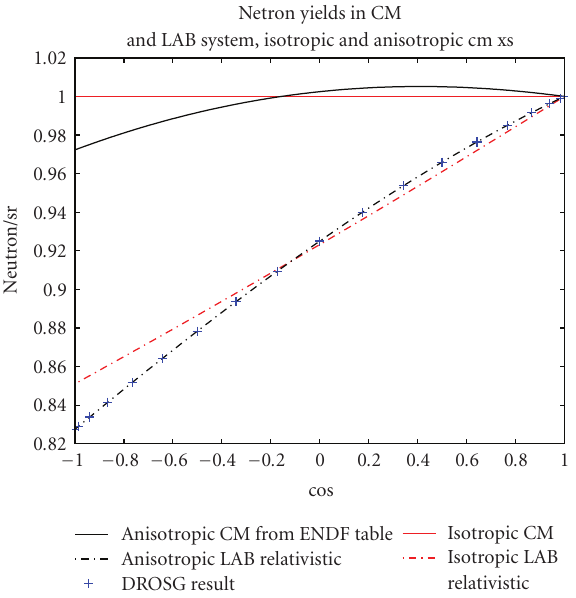
Figure 3: Comparison of isotropic and anisotropic D-T neutron yields in CM and LAB frames.